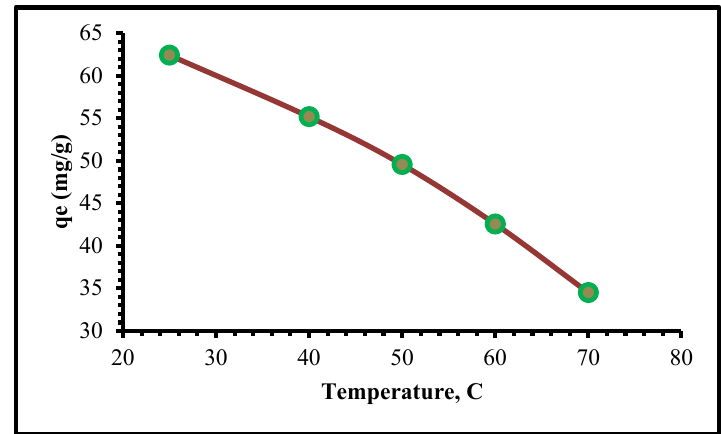
Figure 9. Effect of temperature on the adsorption of Cr(VI) upon TIHP.